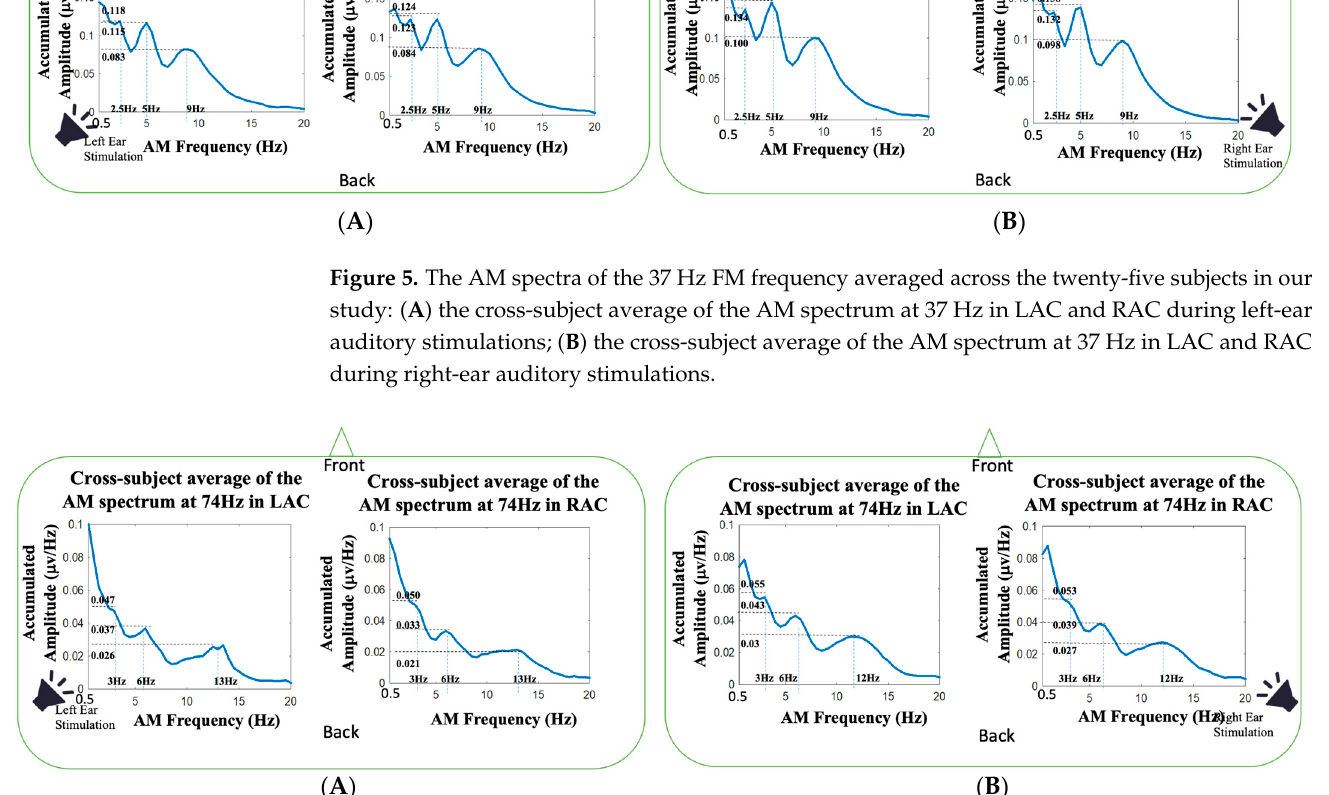
Figure 6. The AM spectra of the 74 Hz FM frequency averaged across the twenty-five subjects in our study: ( A ) the cross-subject average of the AM spectrum at 74 Hz in LAC and RAC during left-ear auditory stimulations; ( B ) the cross-subject average of the AM spectrum at 74 Hz in LAC and RAC during right-ear auditory stimulations.